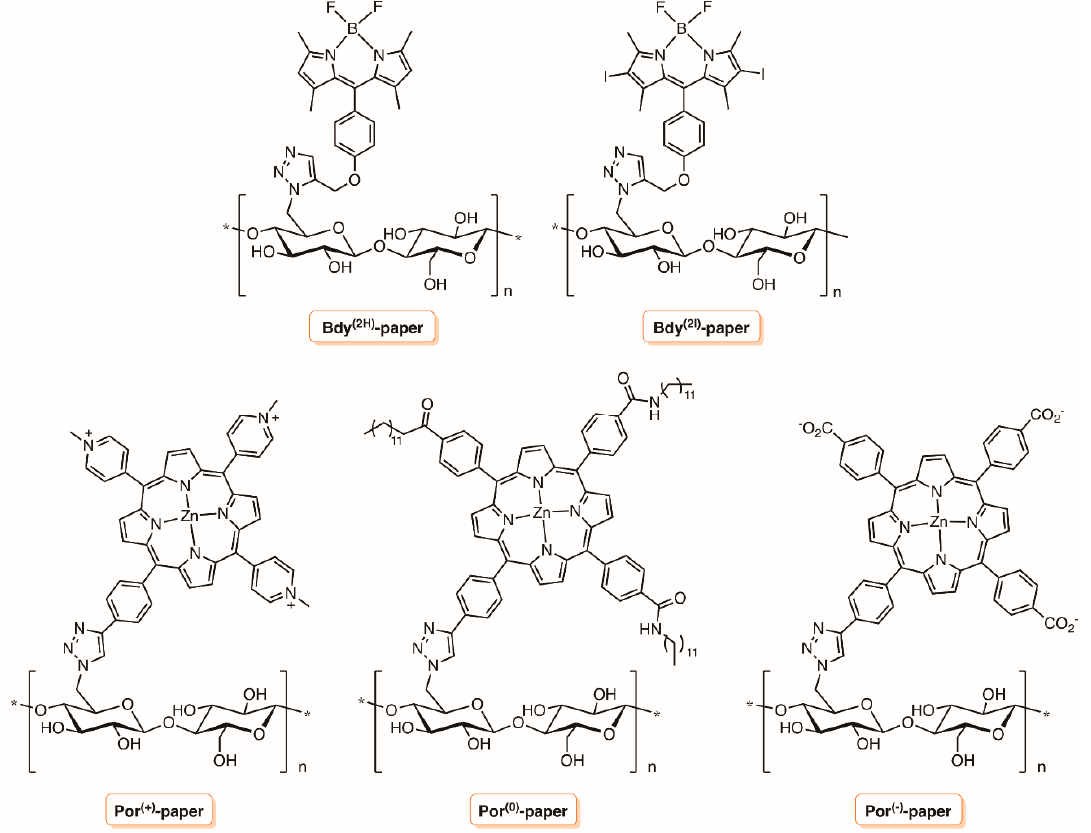
Figure 27. Structure of the antimicrobial filter paper bearing different porphyrins and BODIPY (adapted from Reference [136]).